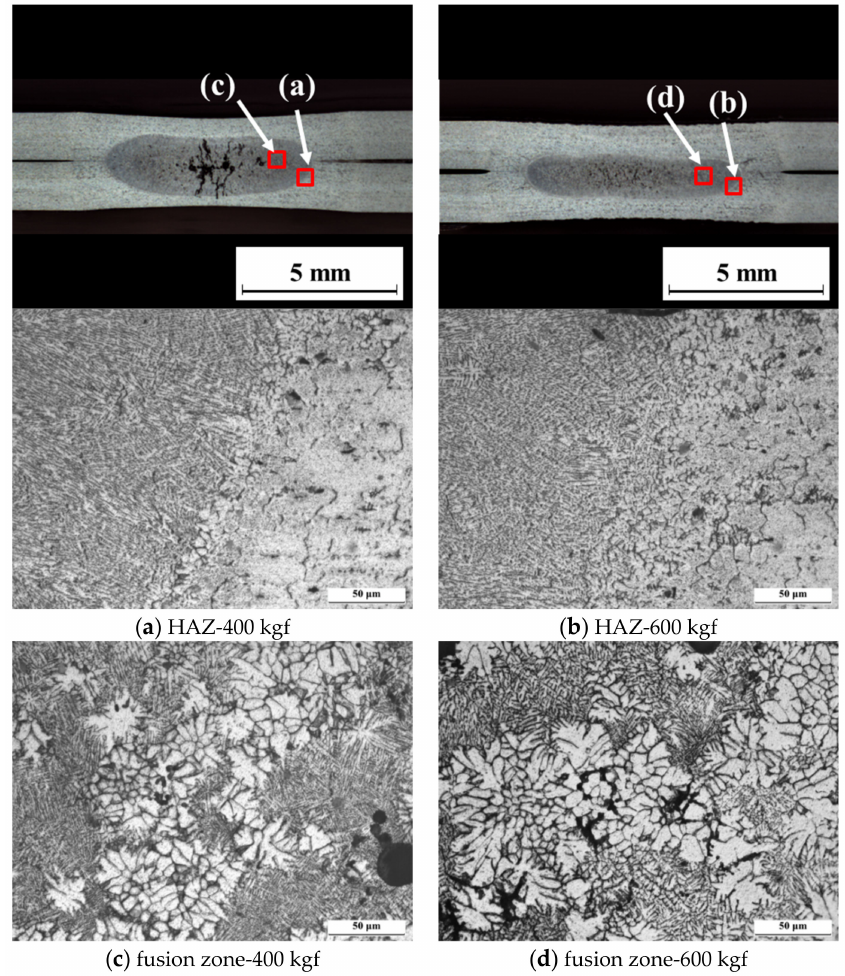
Figure 6. Microstructures of HAZ and fusion zone obtained with the abraded electrode at electrode forces of 400 kgf and 600